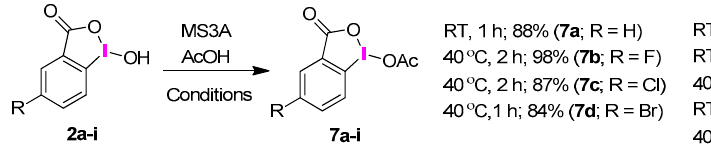
Using AcOH as a solvent, the solvolytic method was further applied to the synthesis